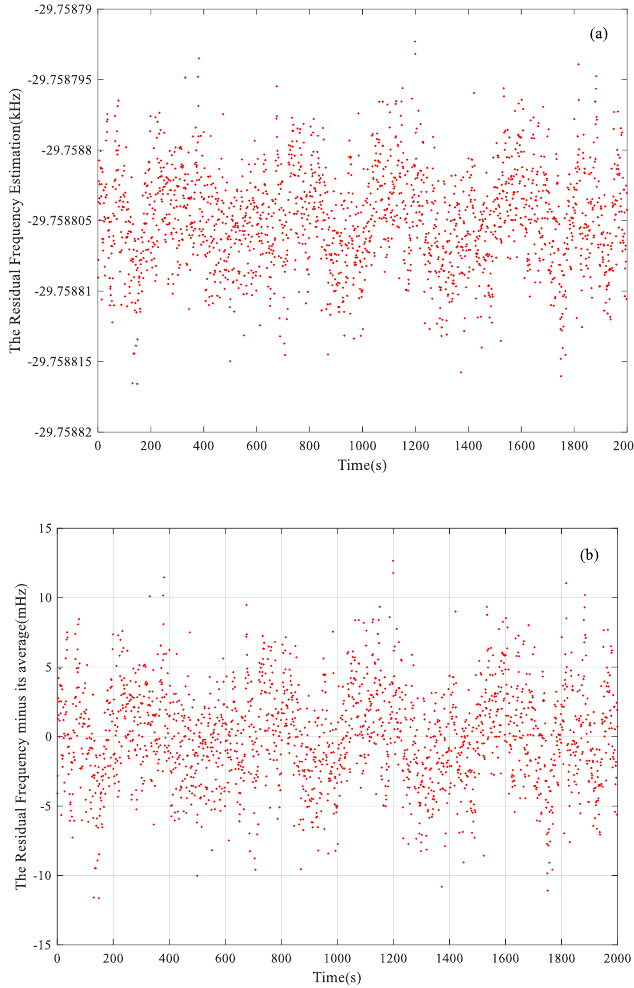
Figure 6. The residual frequency estimation of MEX raw data at JM station, ( a ) the residual frequency estimation; ( b ) the estimation result minus its average value.